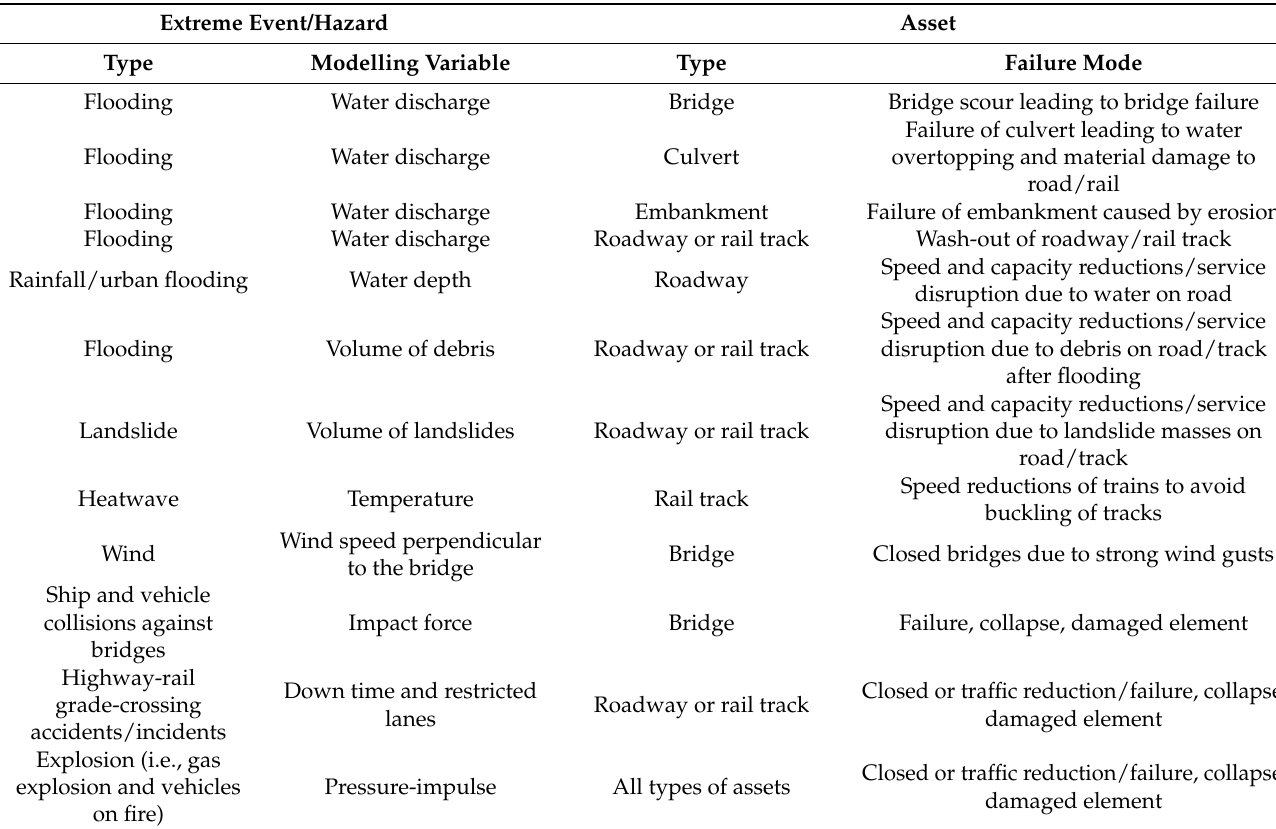
Table 3. Summary of the main parameters for vulnerability and risk